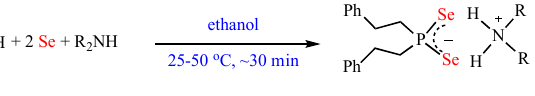
Scheme 13. Synthesis of alkylammonium diselenophosphinates.